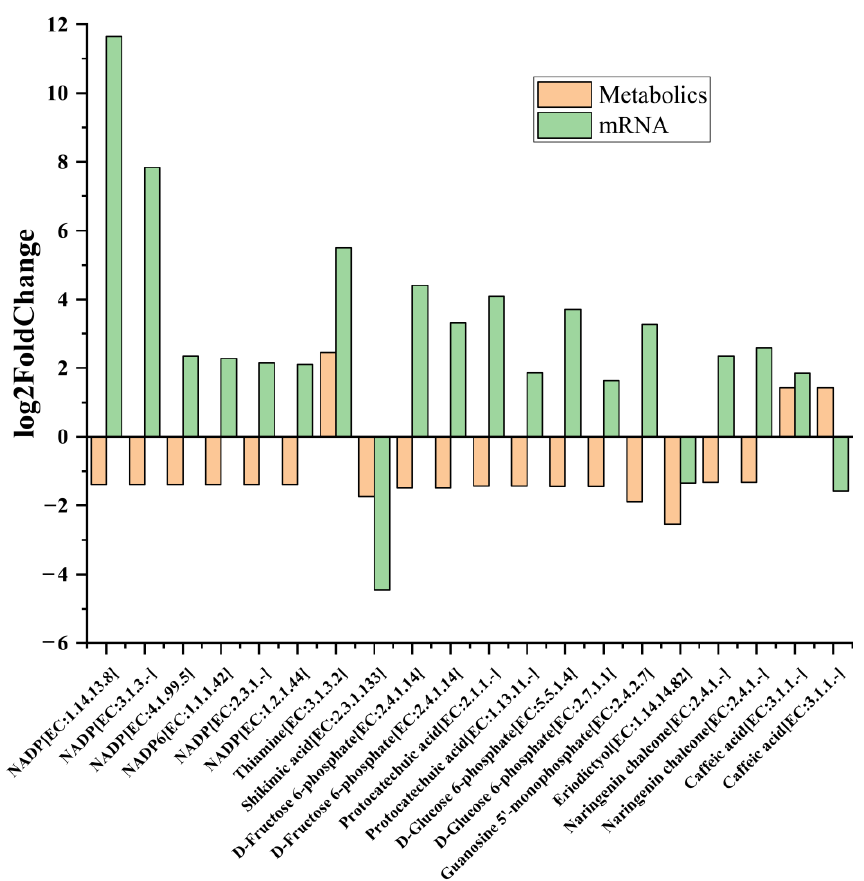
Figure 7. The log2FoldChange of top 20 pairs DAMs and DEGs in co-enriched metabolic pathways ( p < 0.05) with the most obvious difference in MT vs. WT. The analyses used WT as a control. DEGs and DAMs involved in photosynthesis-antenna proteins, porphyrin and chloro- phyll metabolism, and carotenoids metabolism were analyzed (Figure 8). The four LhcB-like1 genes encoding the peripheral light-harvesting antenna protein component (LhcB) in PSII were significantly down-regulated in MT. The genes encoding ferredoxin-NADP reductase leaf isozyme (LFNR2) and cytochrome b6-f complex iron-sulfur subunit PetC) were significantly up-regulated. Additionally, the chlorophyll (ide) b reductase NYC1 gene ( LOC_103501561 ) involved in porphyrin and chlorophyll metabolism, and seven genes en- coding key enzymes of the carotenoids biosynthesis pathway, such as CCD4, ZEP, XanDH, Z-ISO, NCED3, ABAH1, and CISO were all significantly up-regulated in MT (Figure 8A,B). Compound NADP+, the final electron receptor in photosynthetic electron transport chain (ETC), was significantly reduced in MT (Figures 7 and 8C), which may result in the obstruction of electron transfer or electronic leakage. To investigate the consequence of re- duced expression of photosynthetic genes, Western blot analysis was employed (Figure 8D). Whereas the overall proteome patterns were not significantly different in MT vs. WT, pro- teins levels of LhcB2 and PsbB (chlorophyll a binding protein of PSII) were significantly reduced in MT. By contrast, the levels of Toc75 (chloroplast protein transport channel protein) and PPDK (pyruvate phosphate dikinase) were significantly increased in MT compared with WT. These above changes might affect the photosystem activity and ETC electron transfer efficiency, and the yellow-green leaf phenotype of